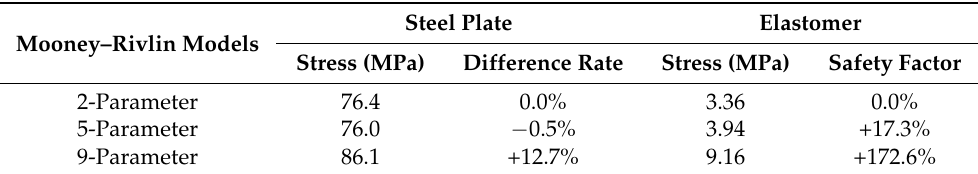
Table 6. Maximum equivalent stresses and its difference rate of the elastomeric bearing with respect to the Mooney–Rivlin model under compression and shear.